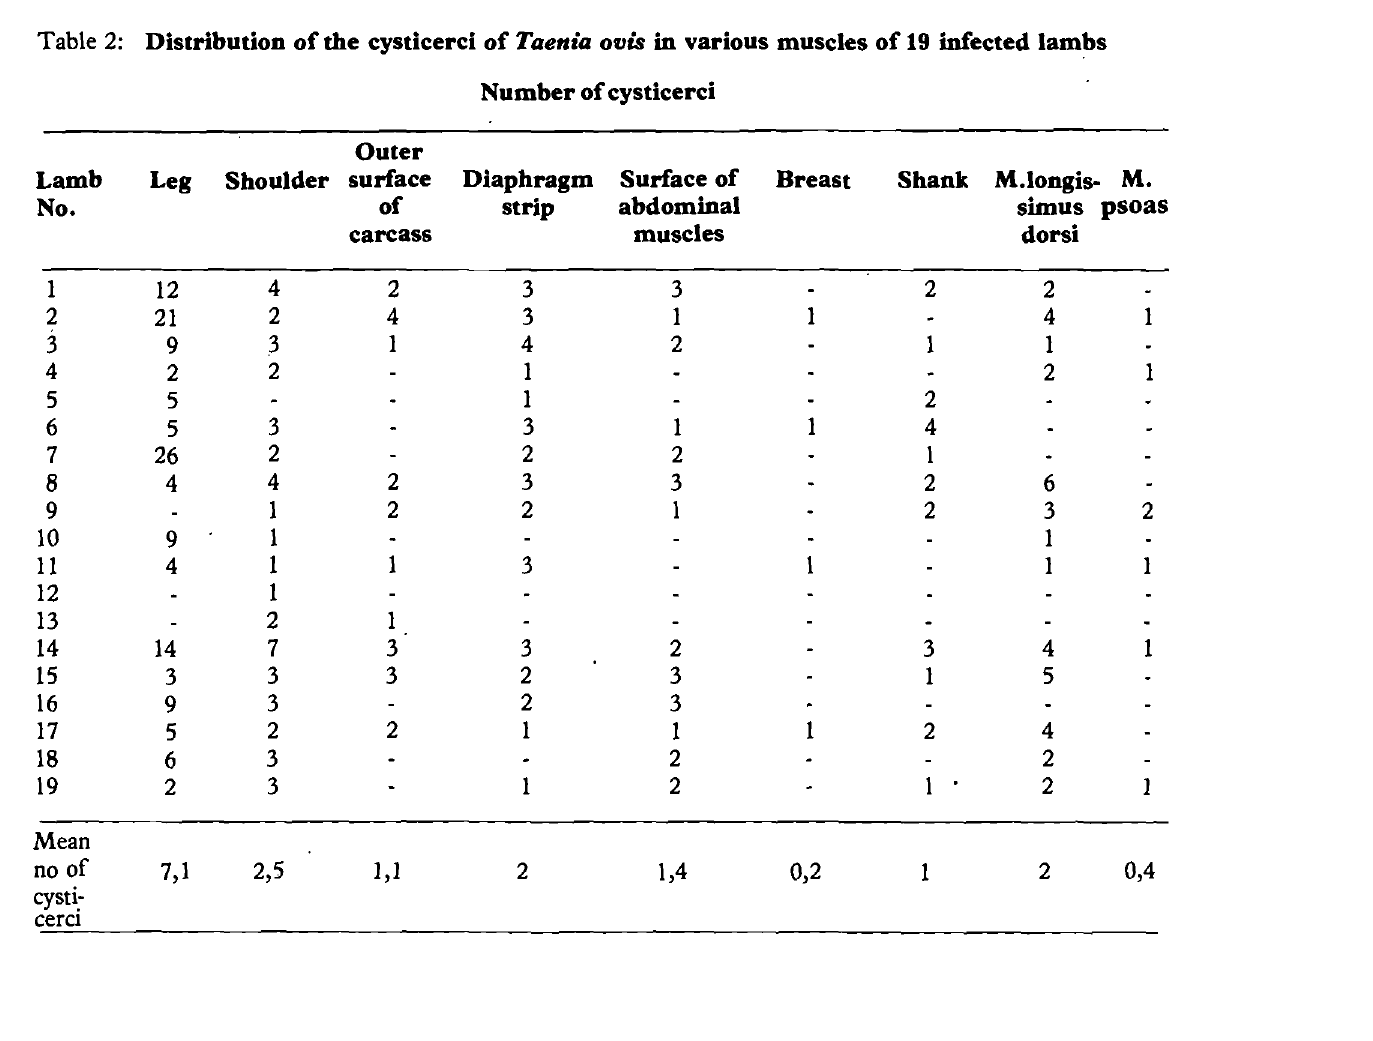
Table 2: Distribution of the cysticerci of Taenia ovis in various muscles of 19 infected lambs Number of cysticerci Outer Lamb Leg Shoulder surface Diaphragm Surface of Breast Shank M.longis- M. No. 2